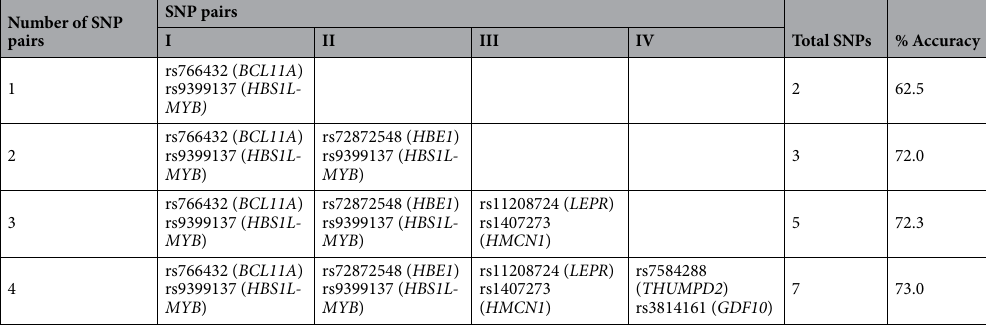
Table 1. SNPs pairs interaction analysis of the GWAS data by iLOCi algorithm searching for predictive SNPs for disease severity of β 0 -thalassemia/HbE